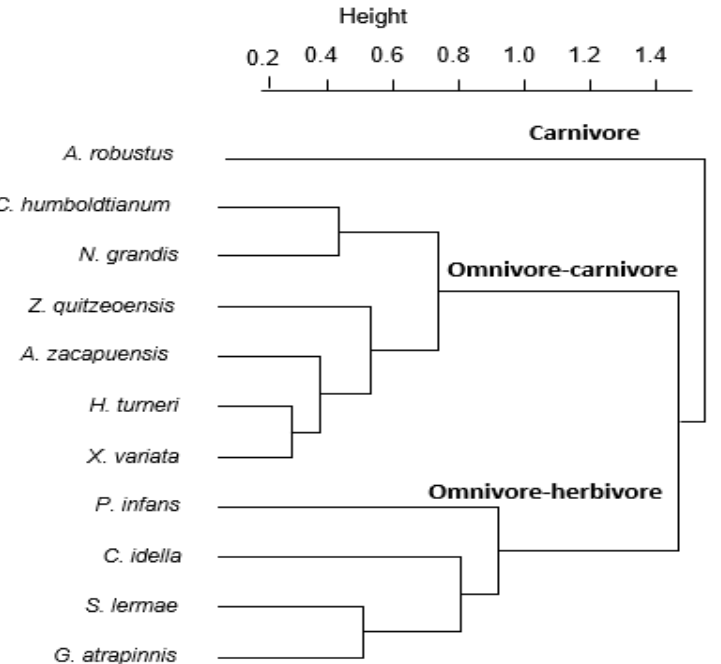
Figure 2. Cluster analysis of the trophic classification of fish species from Lake Zacapu.